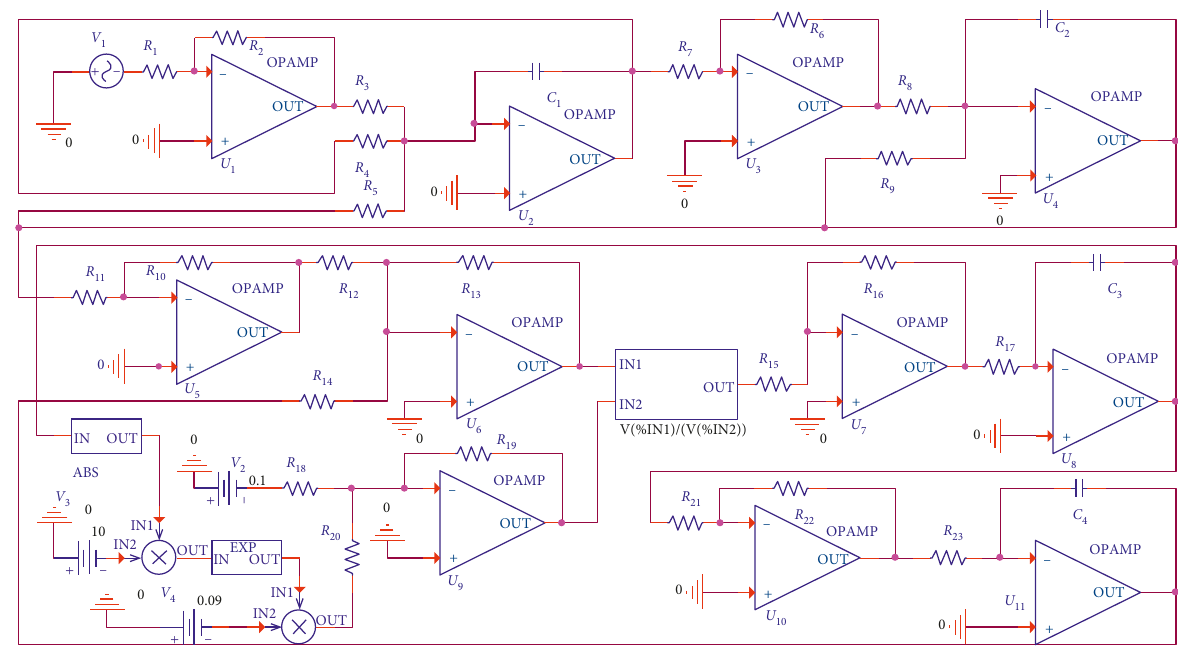
Figure 11: Realization of the circuit by